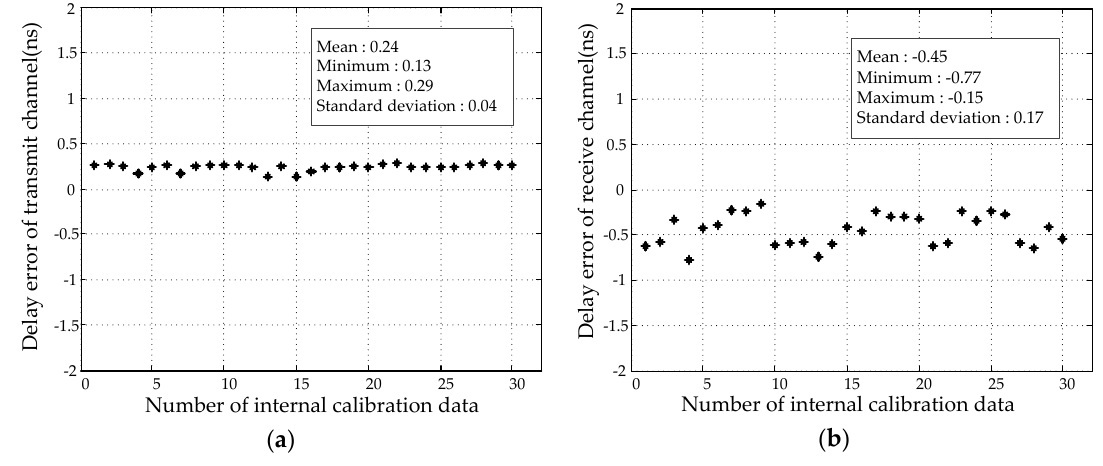
Figure 3. Sampling delay error of ( a ) transmit channel and ( b ) receive channel extracted by internal calibration. internal